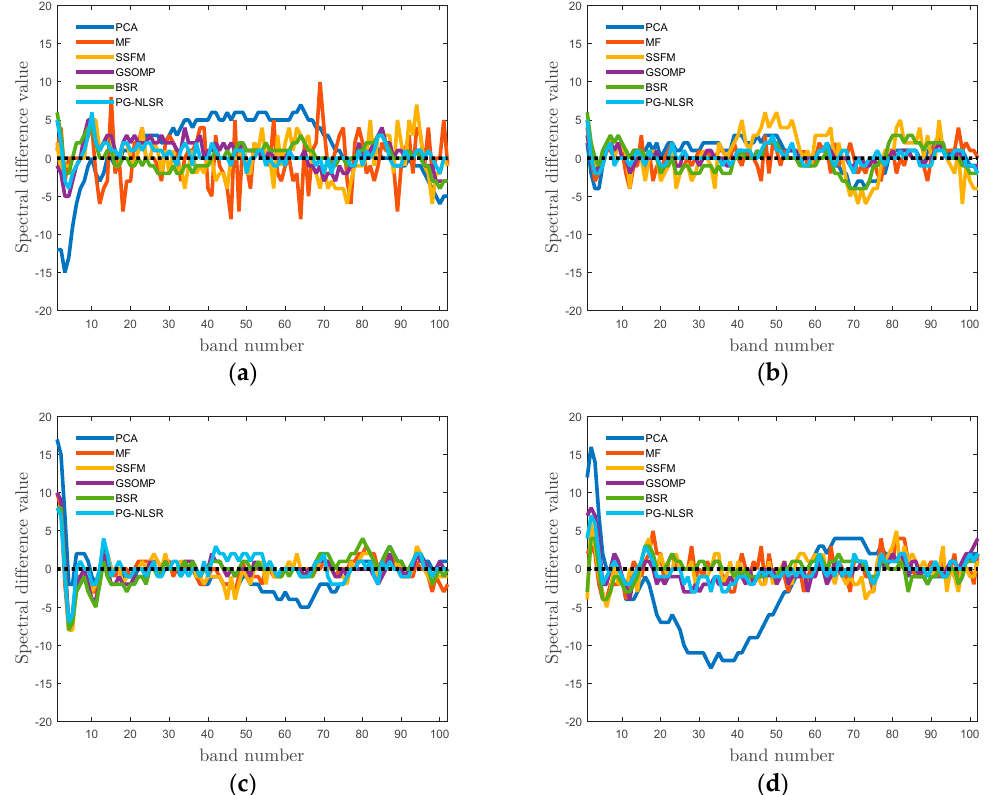
Figure 13. Spectral reflectance difference values on four single pixels of the Pavia Centre image: ( a ) (50, 50); ( b ) (100, 100); ( c ) (150, 150); and ( d ) (180, 200).